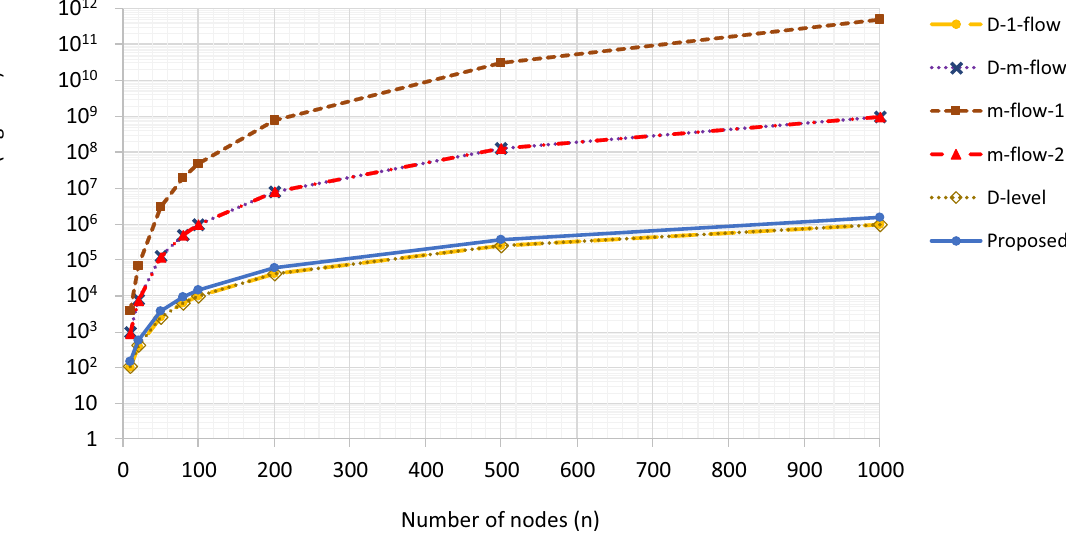
Figure 3. Comparison between selected models based on the number of